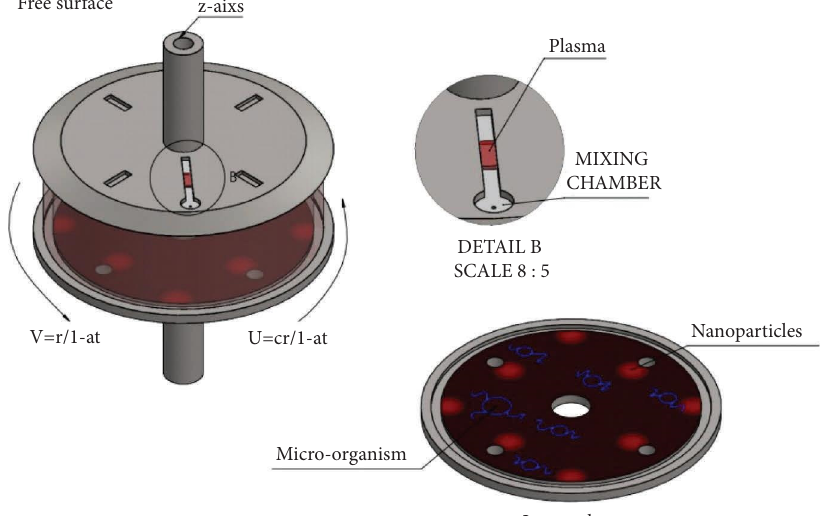
Figure 1: Schematic representation of microbe-containing circular disc microfuidics device mounted on a